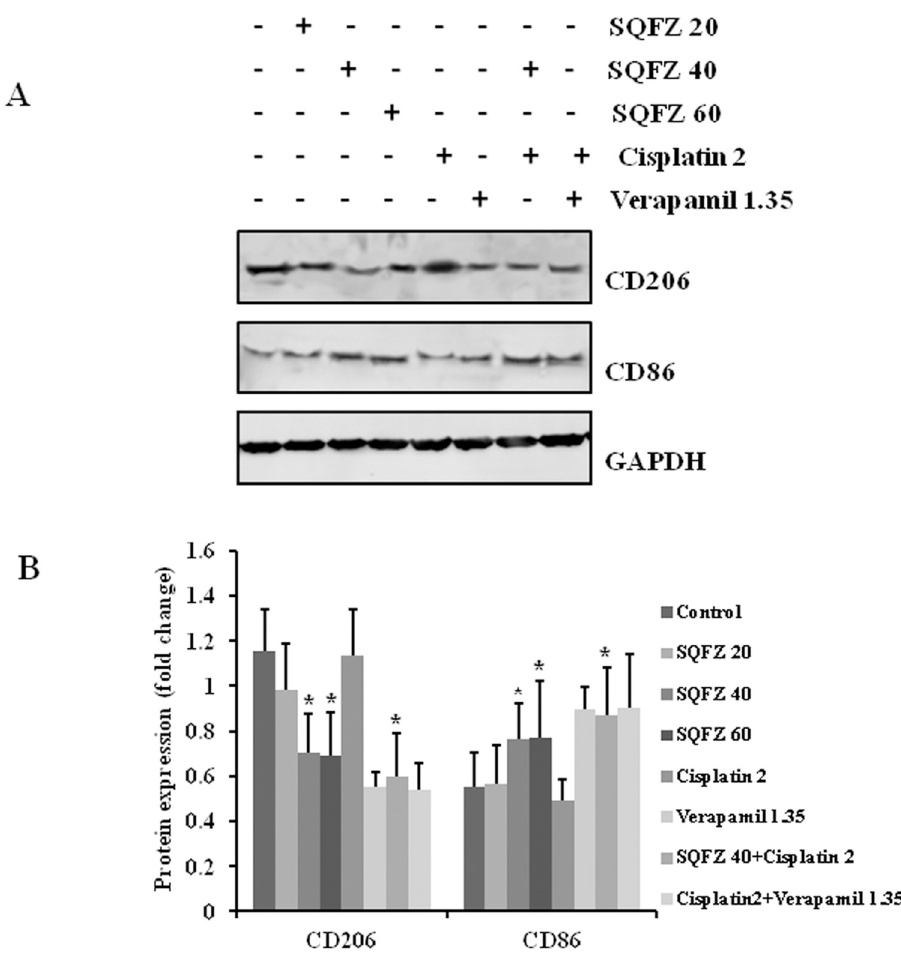
Fig 2. Effects of SQFZ or SQFZ + Cisplatin on the expressions of CD206 and CD86 in MDA-MB-231/DDP+M2 xenografts. Tumour lysates were analysed for the expression of CD206 and CD86 using the respective antibodies. The density ratio of detected proteins to GAPDH is shown as the relative expression. Values are shown as the means ± SD from three independent experiments. � p < 0.05 as compared to Cisplatin alone.